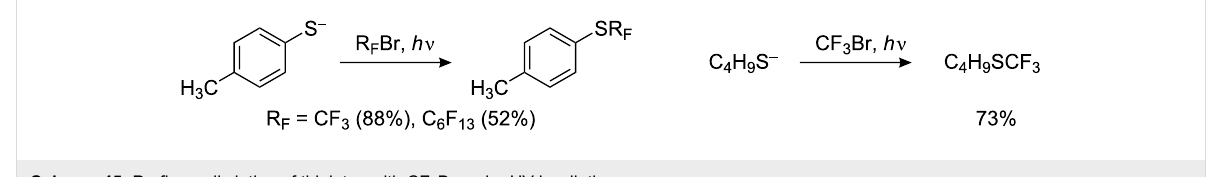
Table 5: Yields of CF 3 Br reaction with thiophenoxides in DMF at 20 °C under pressure (2–3 atm) [178]. Substituents in thiophenols Yields of ArSCF 3 , %